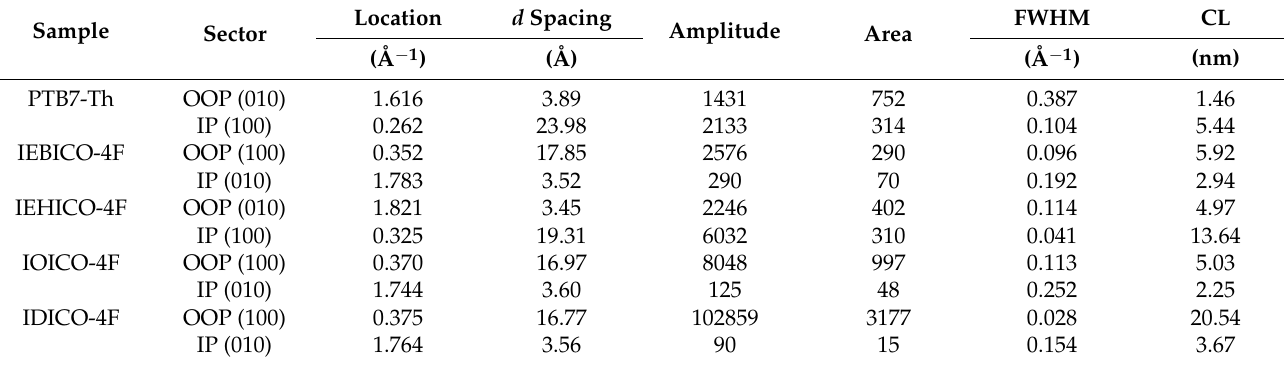
Table 3. GIWAXS parameters of PTB7-Th and IRICO-4F neat films.